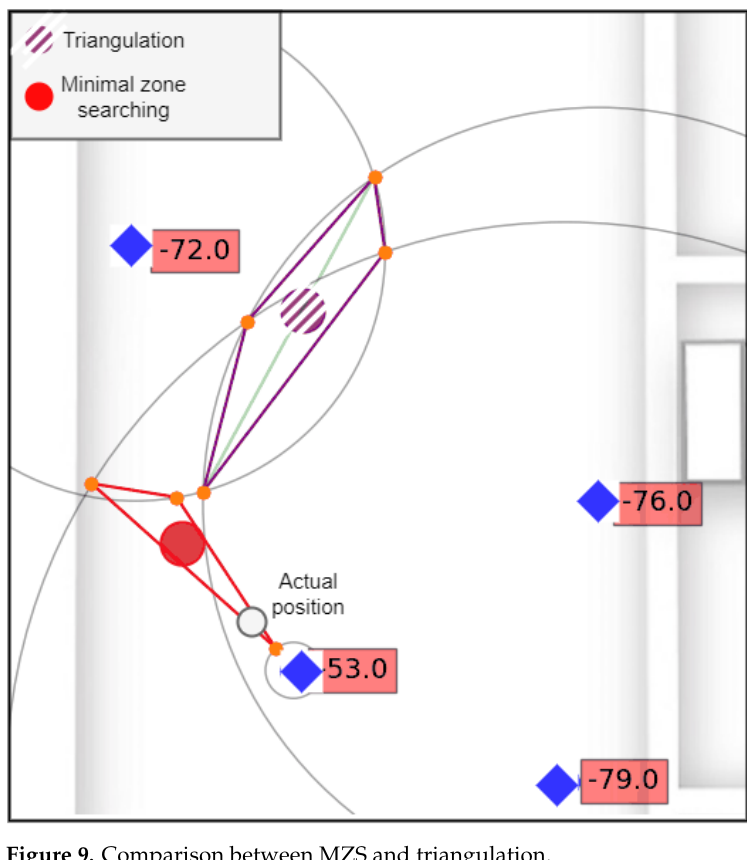
Figure 9. Comparison between MZS and triangulation.